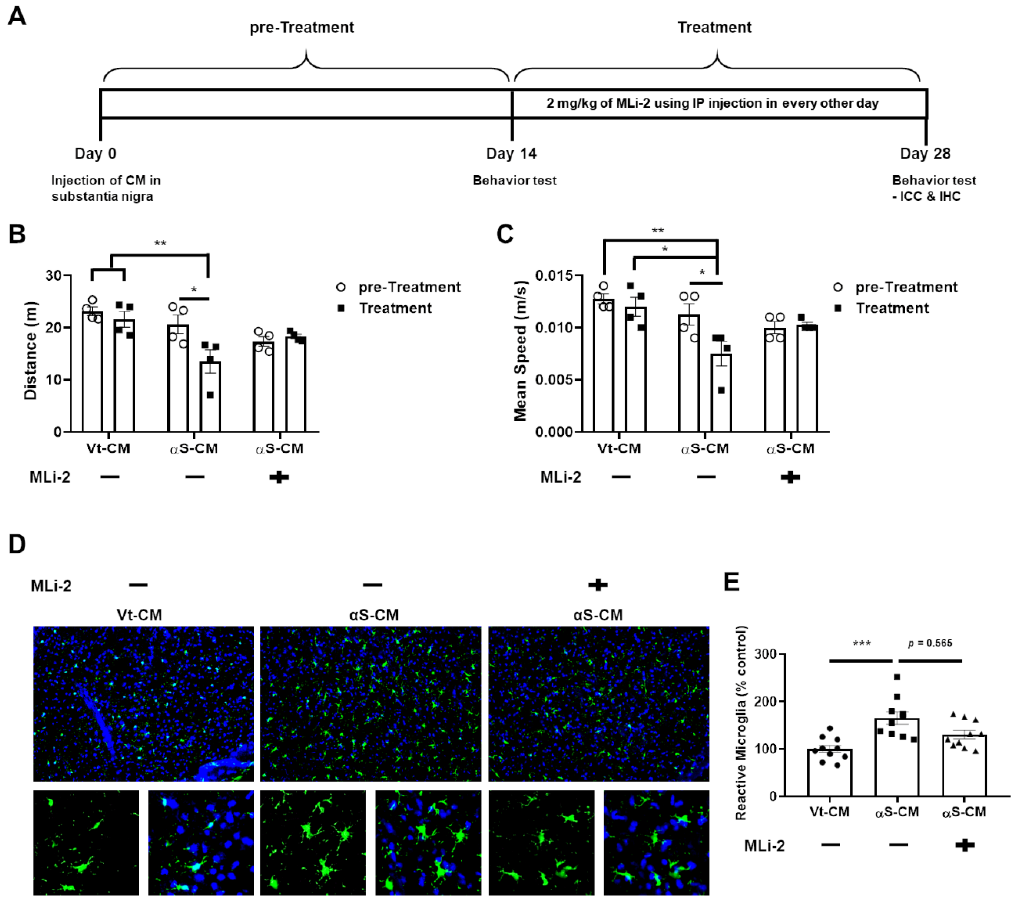
Figure 6. LRRK2 inhibitor prevented further progression of PD caused by neuron ‐ released α Syn.